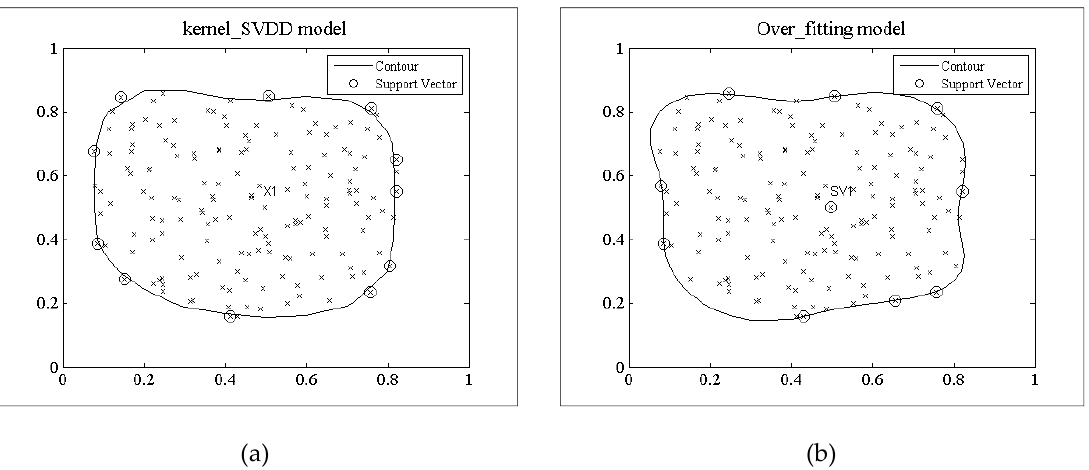
Figure 4. Over-fitted model ( a ) Trained model of kernel_SVDD algorithm; ( b ) Trained model of TRFF algorithm.